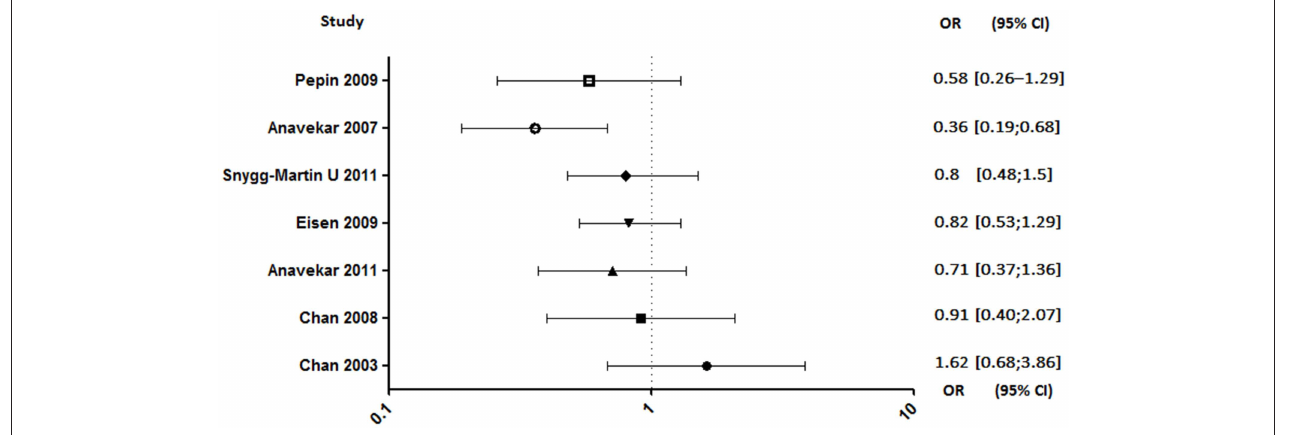
FIGURE 5 | Embolic rate between aspirin and no aspirin users. Odds ratio (OR), 95% confidence interval (95% CI) (4,